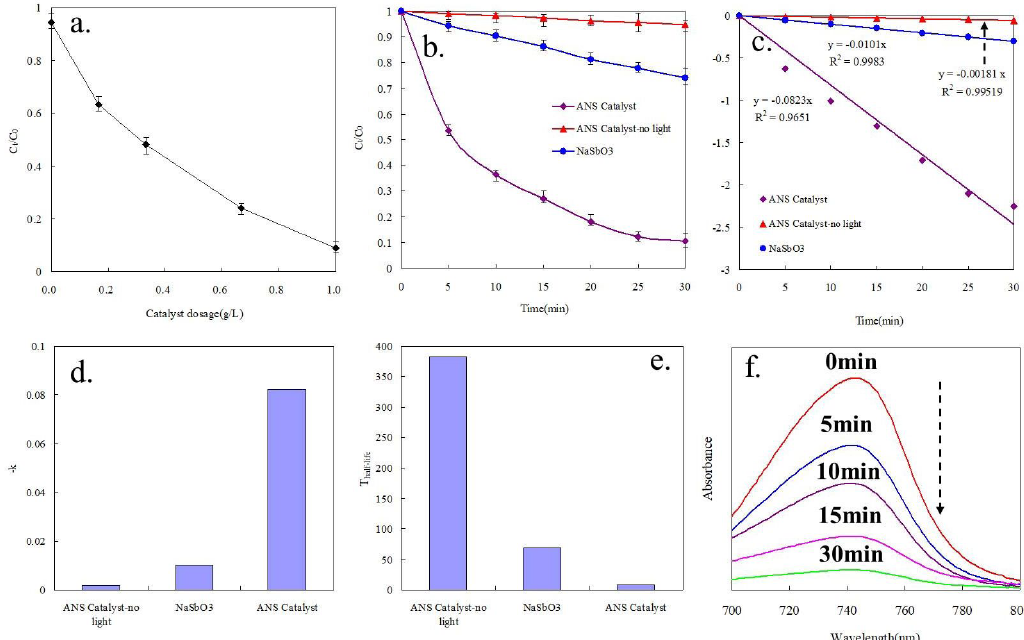
Figure 9. (a) The effect of ANS Catalyst dosage on the removal rate of MB; (b) The photodegradation effect of ANS Catalyst under visible light, NaSbO , and ANS Catalyst with no light; (c) the apparent fitting findings using the pseudo-first-order model; (d) the constants 3 of first-order reactions for MB photodegradation; (e) The half life of photocatalysis reactions; (f) UV-visible absorption spectra of MB solution degraded by ANS